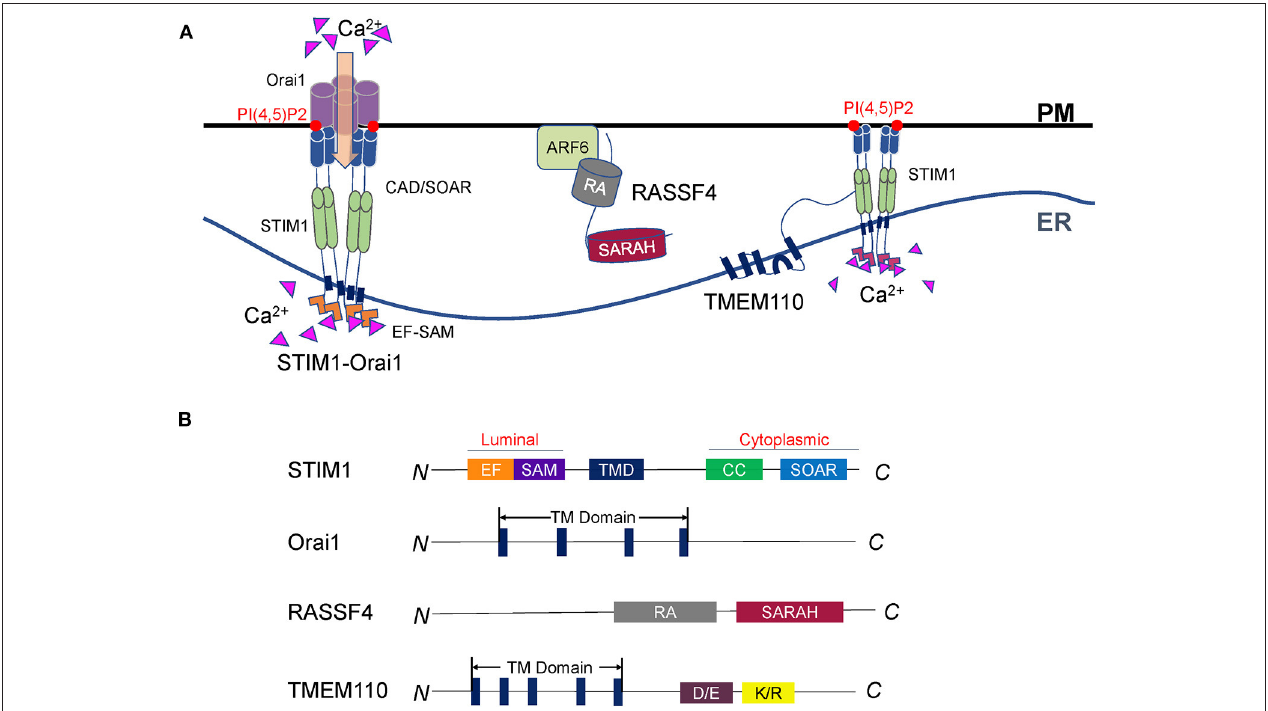
FIGURE 2 | Regulation of Ca 2 + dynamics at ER-PM contact sites. (A) Representative illustration of the STIM-Orai complex and its regulators. STIM1 in the ER and Orai1 on the PM compose the core machinery of SOCE. STIM1 senses the Ca 2 + change in the ER lumen and forms oligomers. The STIM1 oligomers bind to polyphosphoinositides and activate Orai1 to import extracellular Ca 2 + . RASSF4 regulates SOCE and ER-PM junction through the control of the PM PI(4,5)P2 level, which is essential for the localization of STIM1. TMEM110 is an ER membrane protein that physically interacts with STIM1 to reshape ER-PM connections and facilitate STIM1 conformational conversion. Future studies are required to discover more STIM interacting partners, which is important to understand STIM proteins’ sensing and coupling mechanisms. (B) Diagrams of the SOCE regulators described in A. The major functional domains are shown in each of the